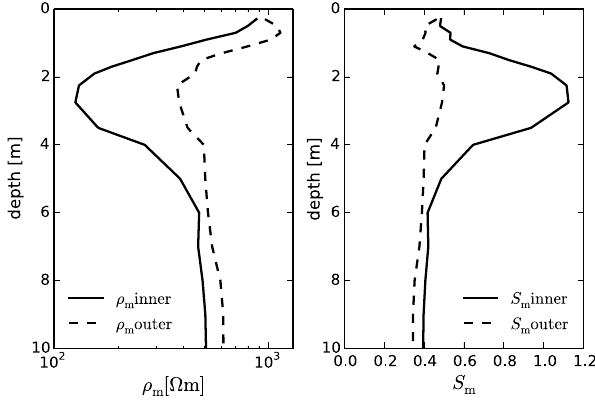
Figure 6. Median resistivity (left panel) and median water satura- tion (right panel) per depth for the inner region (between the depres- sion lines) and outer region (hillslopes) (date: 21 October